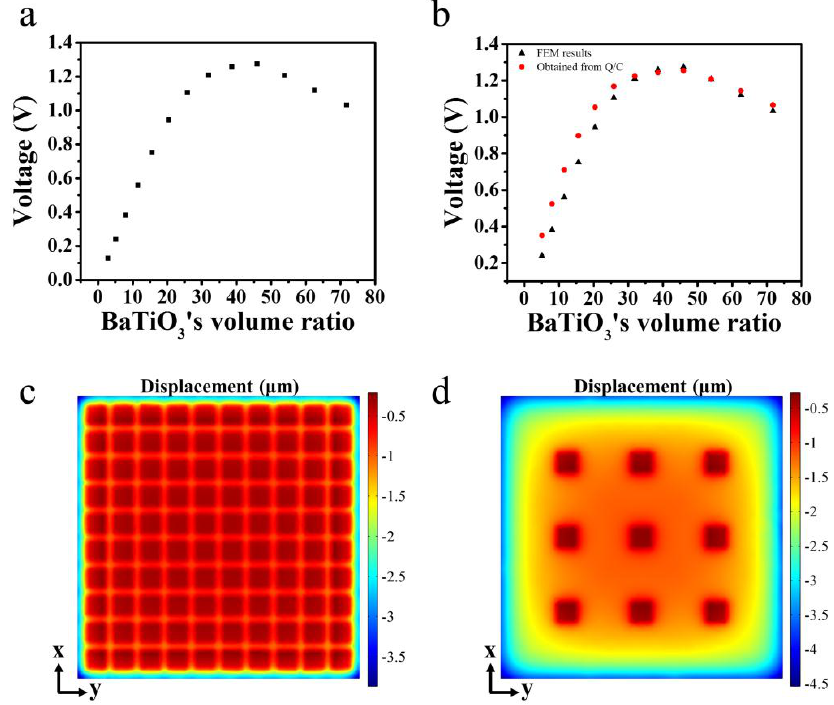
Figure 2. ( a ) The open circuit voltage of the composite PENG containing different volume ratios of BaTiO 3 cubes; ( b ) The comparison of the voltage obtained Q / C and that directly calculated from the coupled piezoelectric governing equation. The distribution of stress on the BaTiO 3 cubes’ top surface with volume ratio of 31.9% ( c ) and 2.9% ( d ).